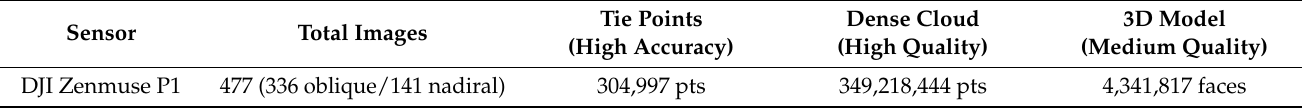
Table 3. Photogrammetric process via Agisoft Metashape.